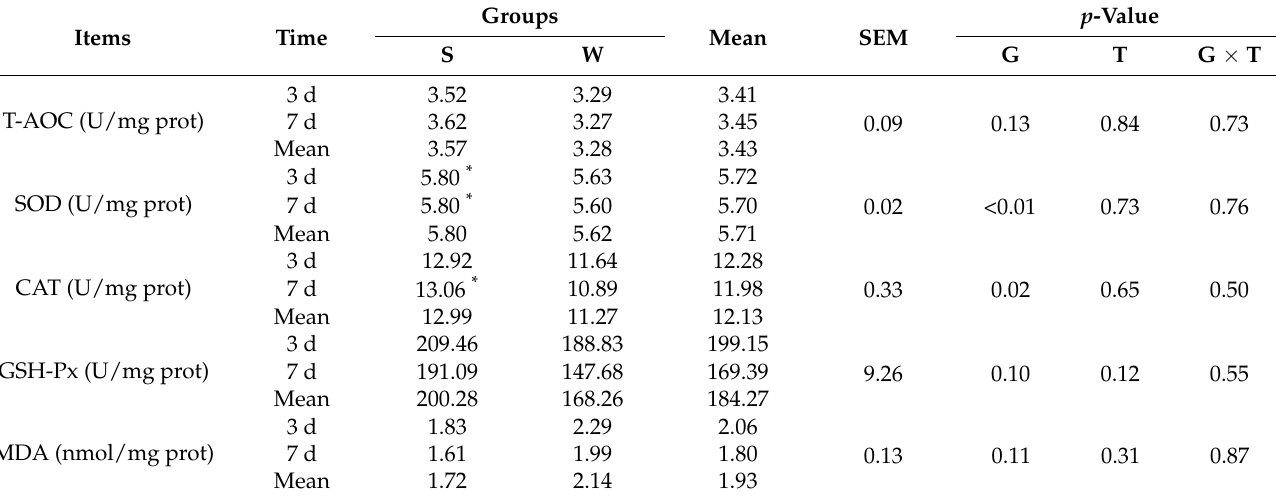
Table 5. Effects of weaning on antioxidant function of liver of piglets.